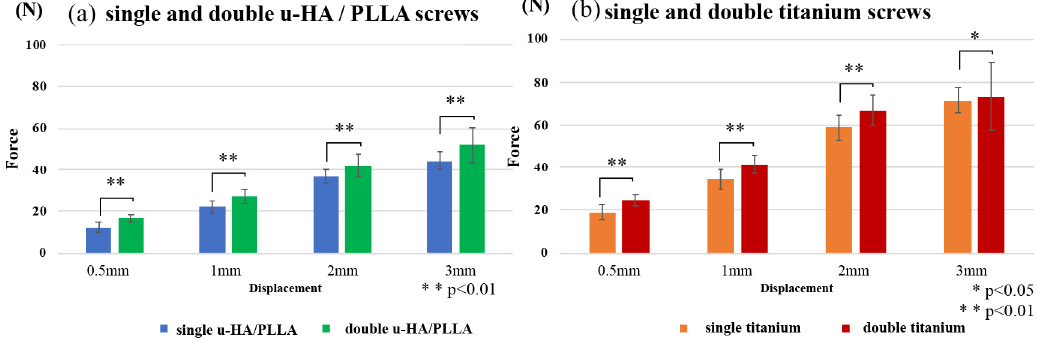
Figure 8. Vertical loading tests. These graphs show the comparison of single and double u-HA/PLLA screws ( a ) and comparison of single and double titanium screws ( b ).